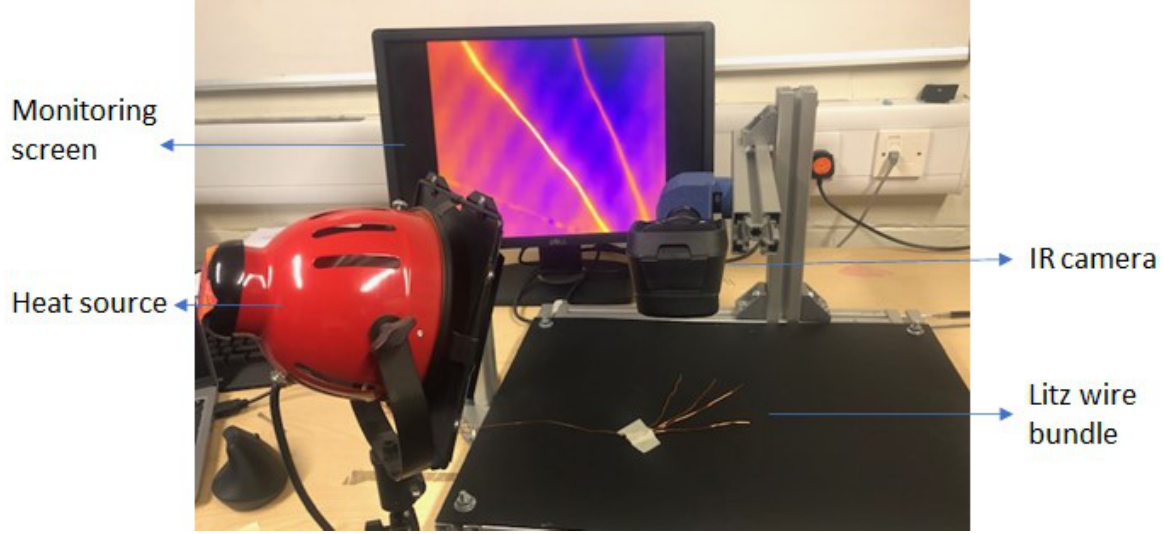
Figure 2. A picture of the setup used for experiments using the IR camera.